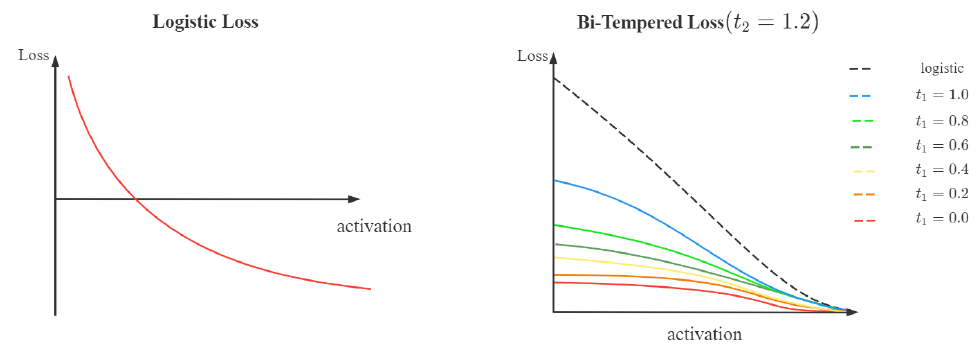
Figure 16. Logistic loss and Bi-Tempered loss curves.